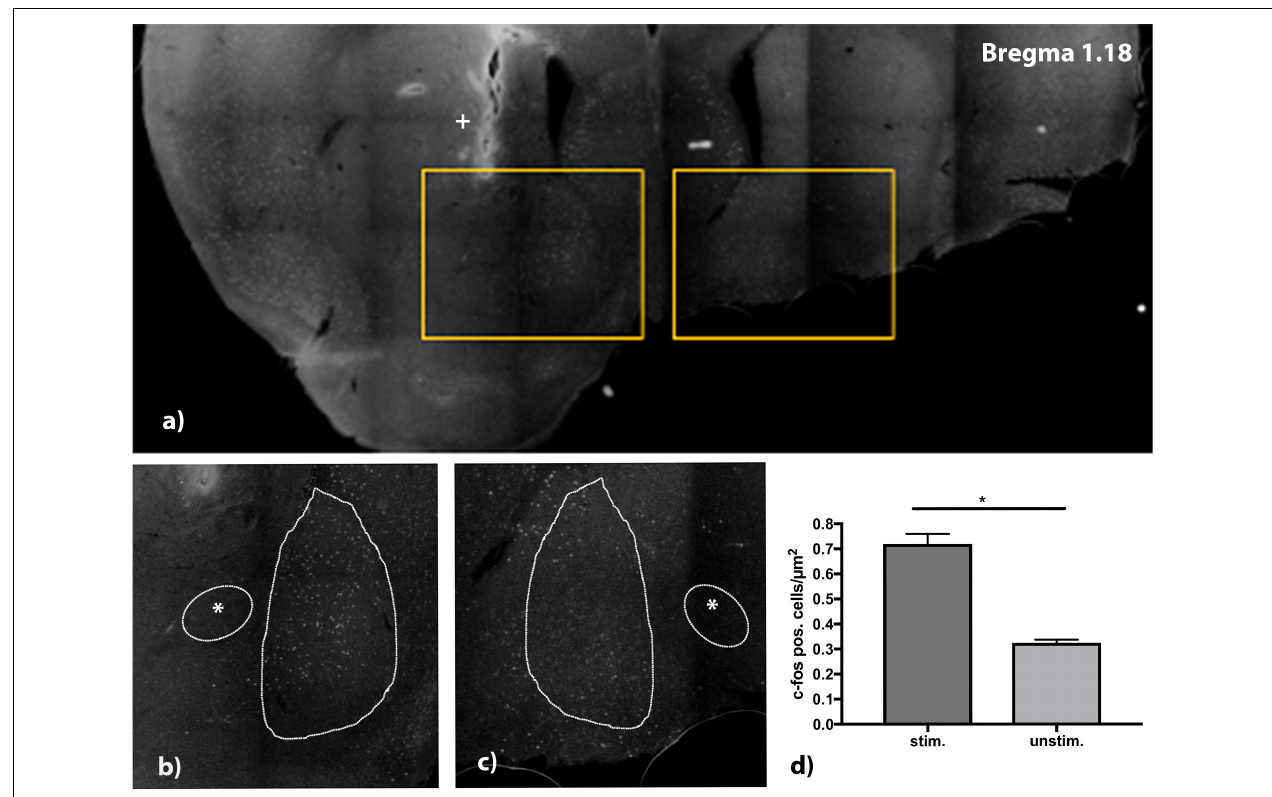
FIGURE 5 | (a) C-fos stained brain slice at Bregma 1.18 mm. Electrode was implanted on the right side aiming at the medial shell of nucleus accumbens. Detail view (b,c) show upregulation of c-fos in the stimulated side (b) vs. lesser expression of c-fos in the unstimulated side. (d) Analysis of stimulated (stim.) vs. unstimulated (unstim.) site with a higher number of c-fos positive cells/ µ m 2 . n = 4 animals, mean number of cells/ µ m2 ± SEM. * Commissura anterior, + Electrode